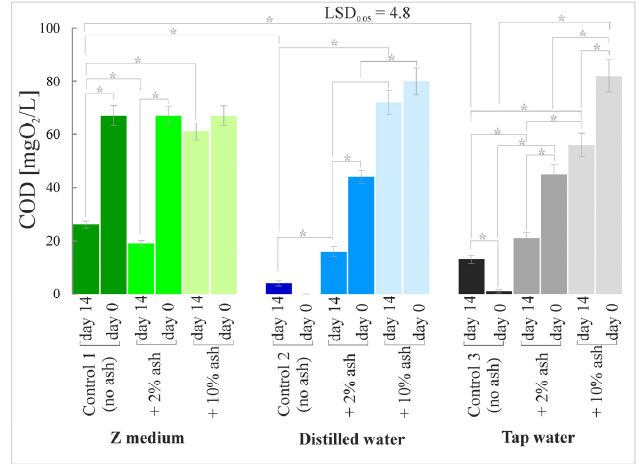
Figure 7. Chemical oxygen demand (COD) in S. polyrrhiza plants grown on different variants of ash-supplemented media. Bars denote means ± SE; asterisks show statistically significant differences between particular series; LSD at alpha level of 0.05.